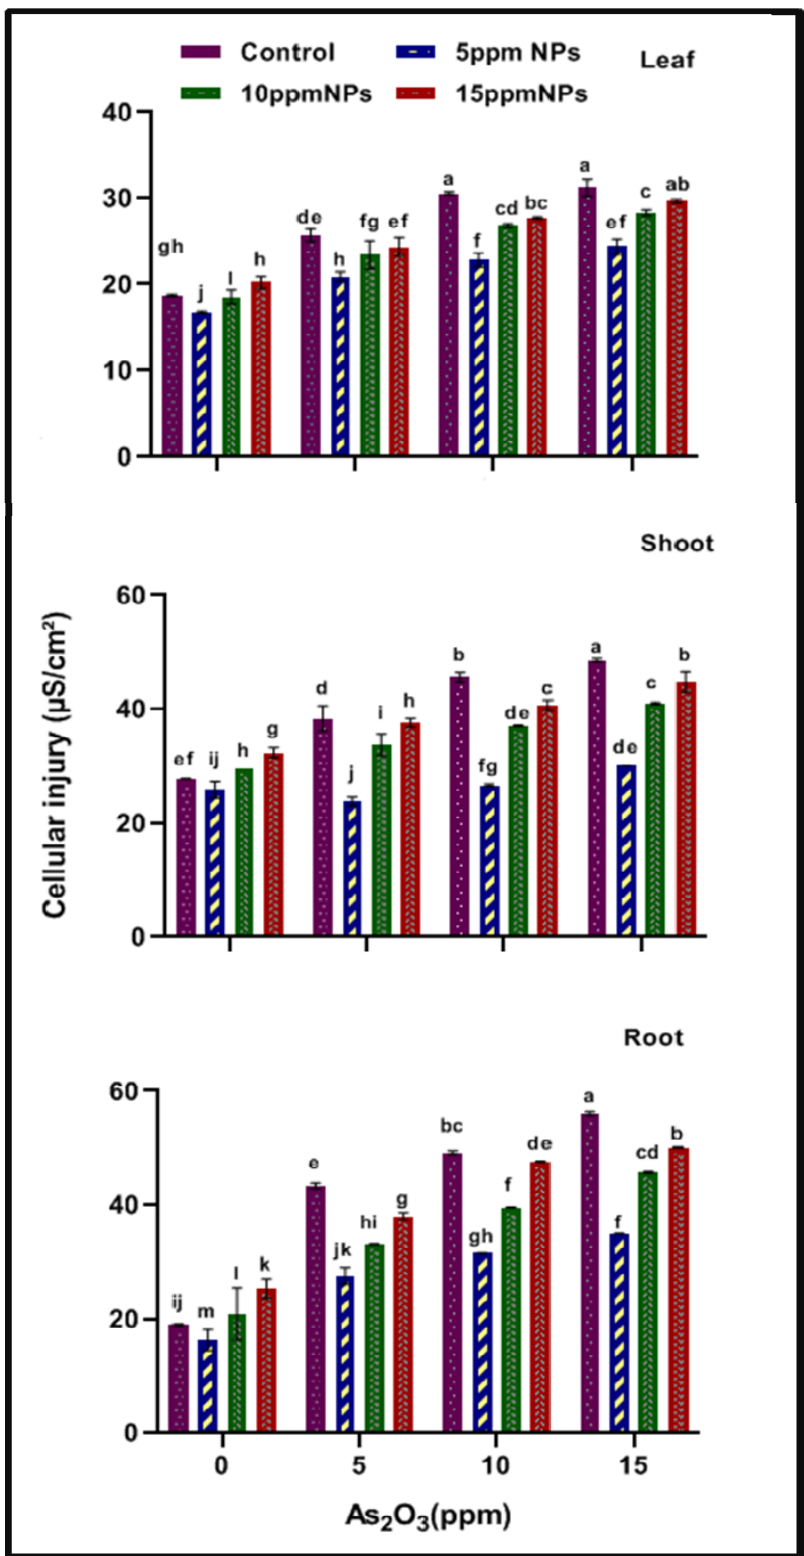
Figure 1. Effect of Bacillus subtilis- synthesized iron oxide nanoparticles on the cellular injury of rice ( Oryza sativa L.) in arsenic contaminated water. Different letters indicate significant differences ( p < 0.05) between treatments.